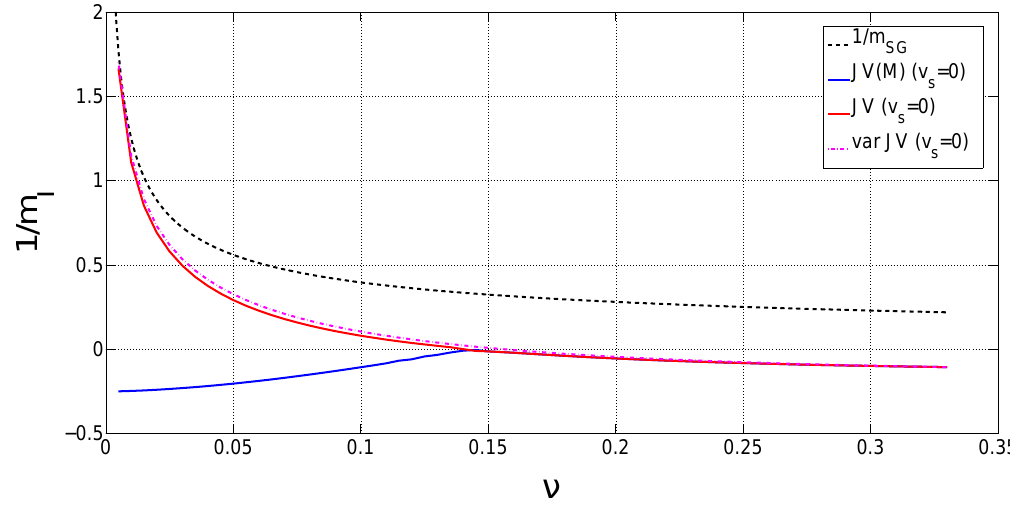
Figure 12: Inverse of the inertial mass for Josephson vortices (upper red full line, labeled ‘JV’) and Josephson vortex maxima (lower blue full line, labeled ‘JV(M)’) at v tunneling strength with γ = 1 obtained from numerical solutions. The magenta dash-dotted line is an approximate result obtained from a variational calculation for Josephson vortices (labeled ‘var JV’), equation (33). The black dashed line shows 1 / m section